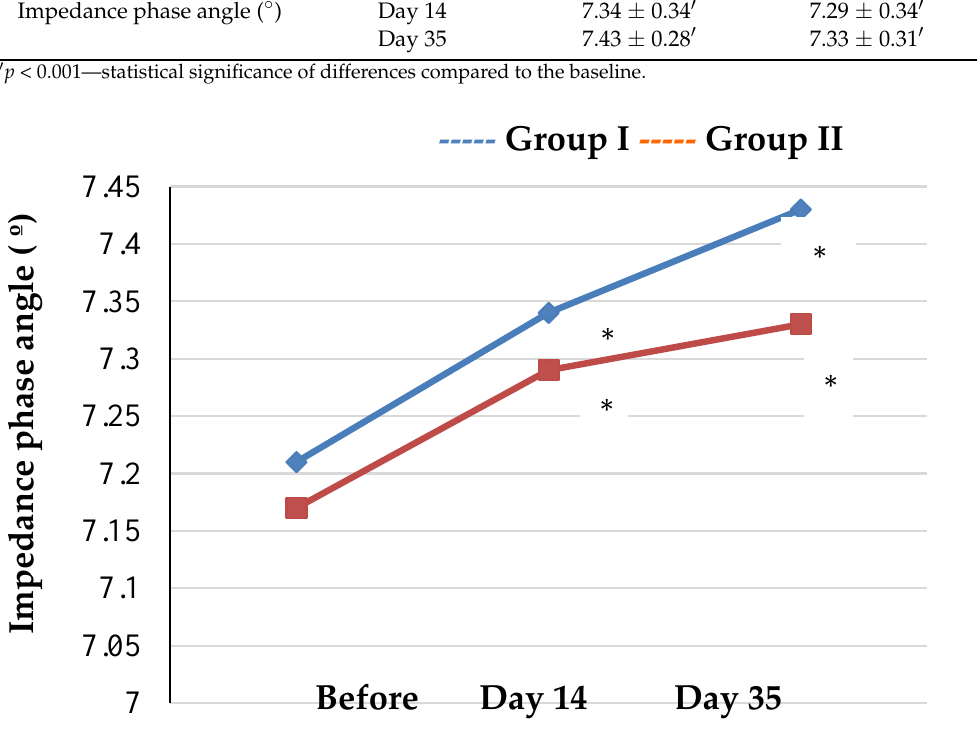
Figure 3. Trends in impedance phase angle of athletes by groups (* p < 0.05—statistical significance of differences compared to the baseline).